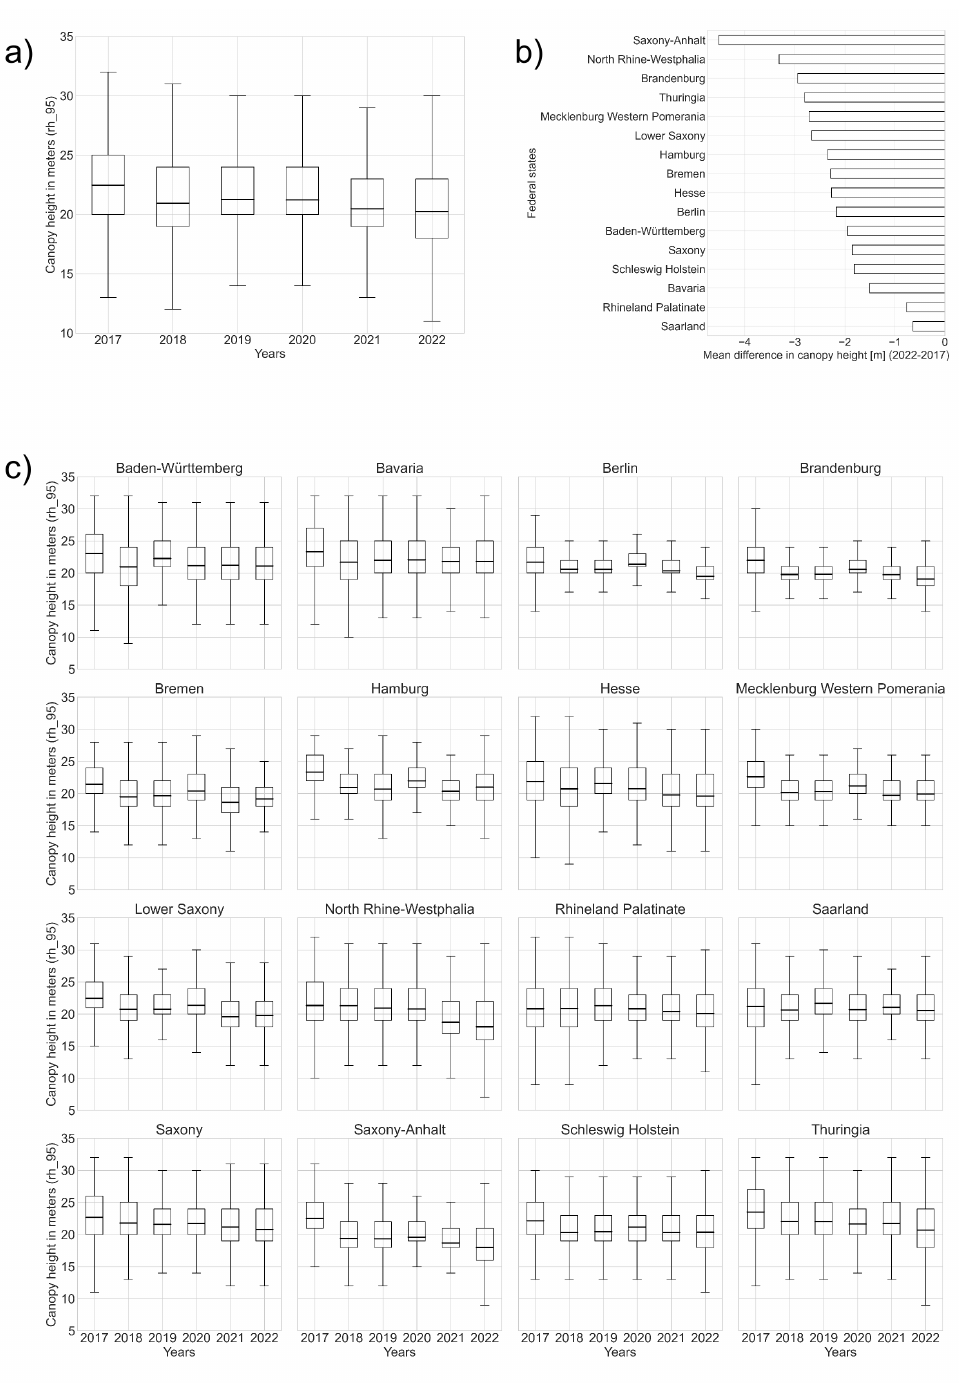
Figure 7. Quantitative statistics of canopy height in forested areas of Germany: Overall dynamics in canopy height in Germany ( a ), mean difference in canopy height (202-2017) among federal states ( b ), multi-temporal change in canopy height grouped by federal states ( c ). The statistics are based on predicted pixel estimates depicting mean values as horizontal line in the boxplots. General dynamics of forest structure are assessed; absolute values should be interpreted in the context of model